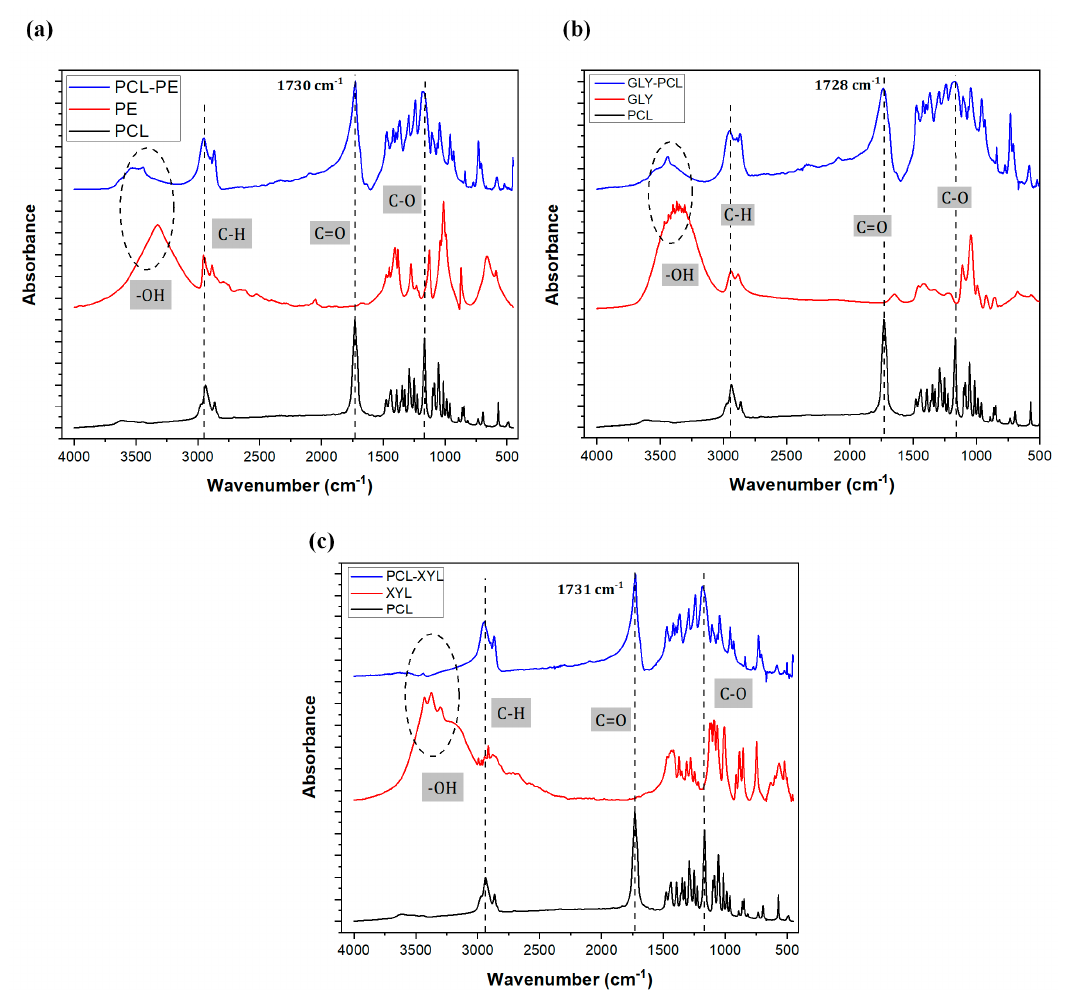
Figure 3. FTIR spectra of PCL and the three prepared branched PCL − copolymers: PCL − PE ( a ), PCL − GLY ( b ), and PCL − XYL ( c ).